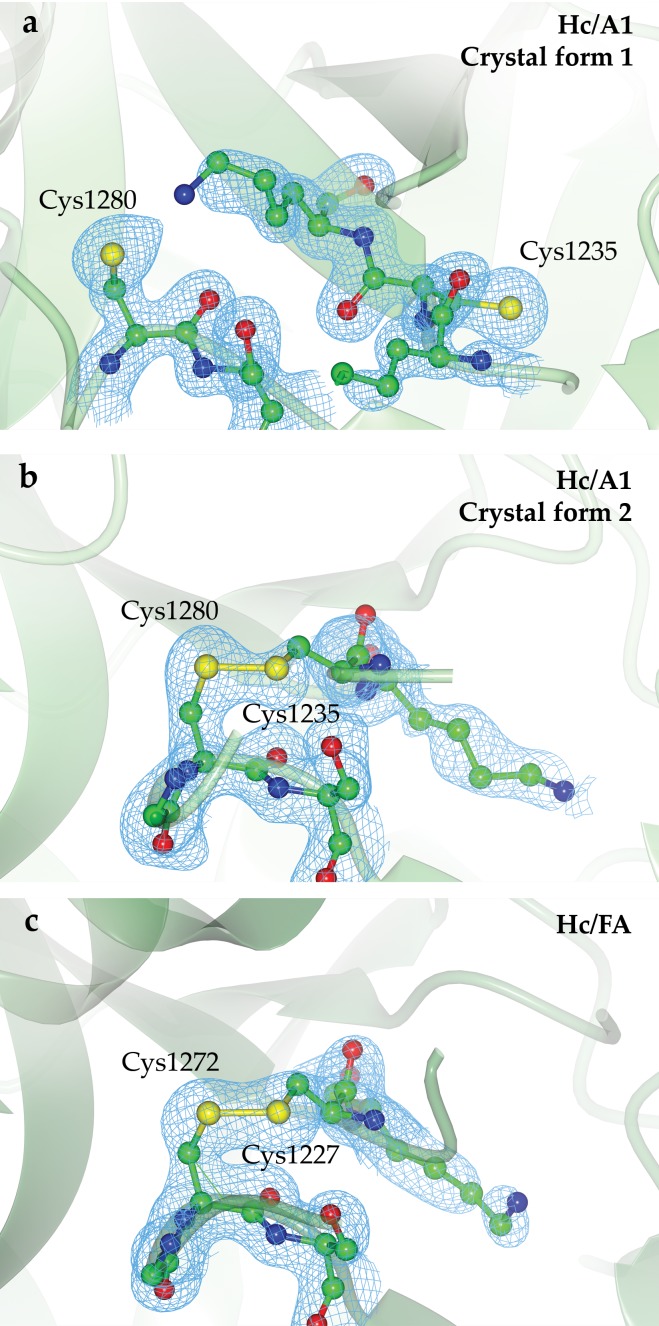
Location of Cys1235 and Cys1280 residues.(A) Cys1235 and Cys1280 are not covalently bound in the HC/A1 crystal form 1, (B) disulphide bond formation in crystal form 2 and (C) a similar disulphide bond is seen in the HC/FA crystal structure between equivalent cysteines. Composite OMIT maps were produced using Phenix (Terwilliger et al., 2008). And are shown for each model at 1 σ. Figure generated using CCP4mg (McNicholas et al., 2011).